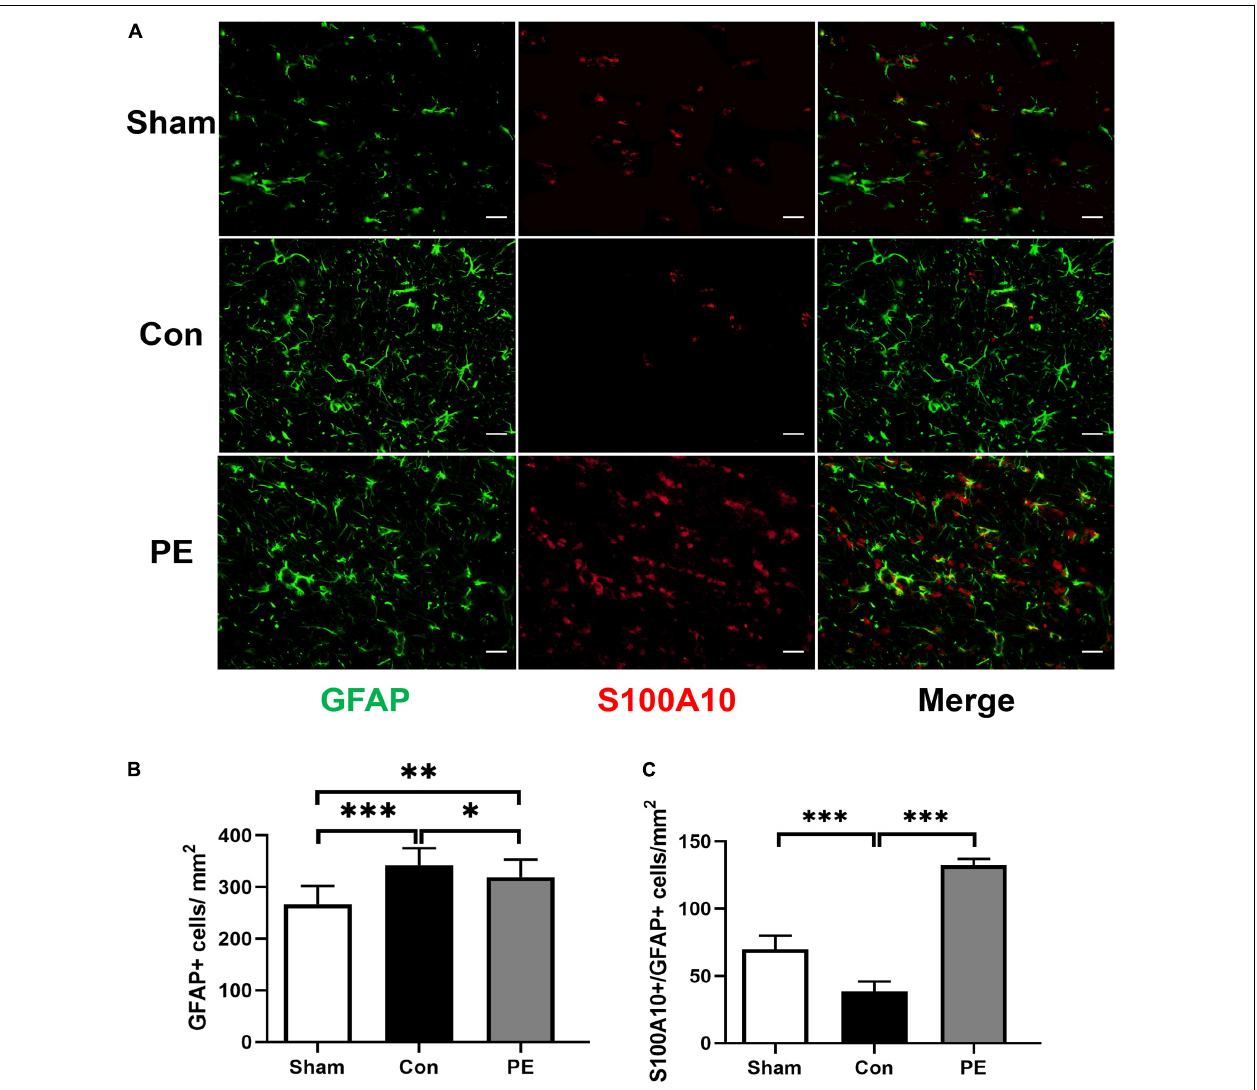
FIGURE 4 | Physical exercise enhanced the expression of A2 neuroprotective astrocytes. (A) Representative immunofluorescence images for GFAP (green) and S100A10 (red) double staining of rats in each group in the corpus callosum. Scale bar = 50 µ m. (B) The quantification of GFAP positive astrocytes and (C) S100A10/GFAP positive A2 astrocytes. n = 6. Experimental data are expressed as the means ± SD. ∗ P < 0.05, ∗∗ P < 0.01, ∗∗∗ P < 0.001. S100A10, S100 calcium binding protein